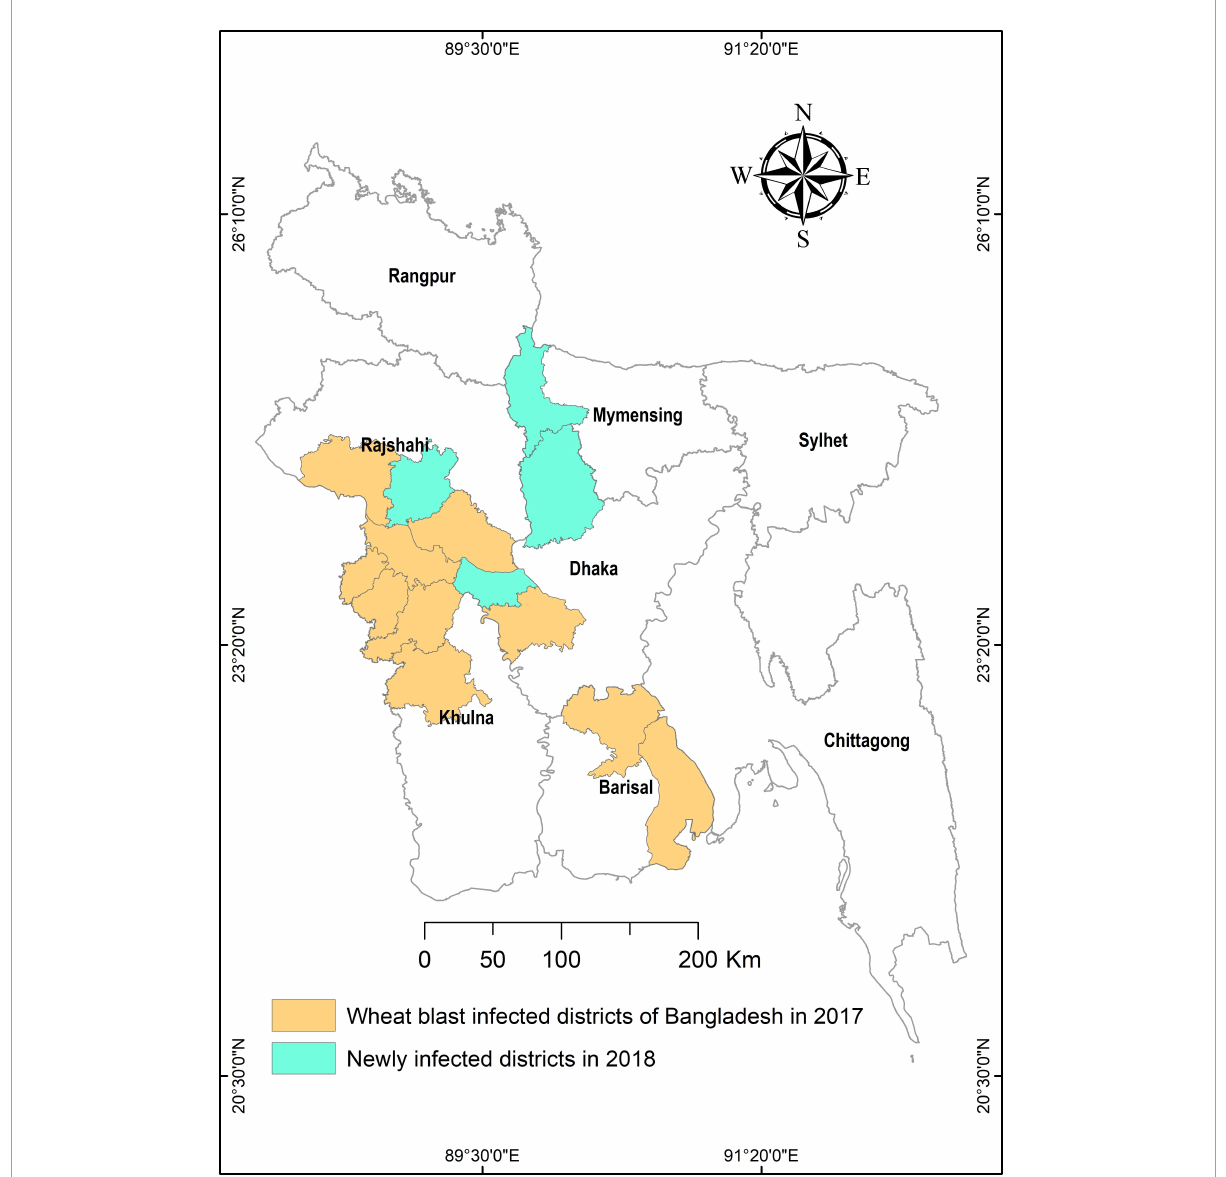
FIGURE2 A map showing blast-infected areas in Bangladesh in 2017 and 2018. The figure is produced using the data of Yesmin et al.